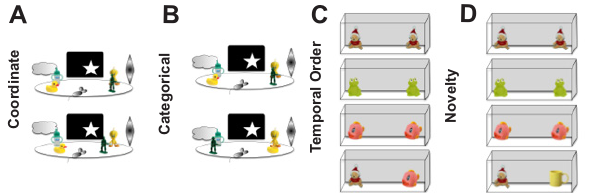
Figure 1. Paradigms used to evaluate spatial and temporal processing in mice. A . Metric or Coordinate change detection task. B . Topological or Categorical change detection task. C . Temporal order for visual objects task. D . Novelty detection for visual